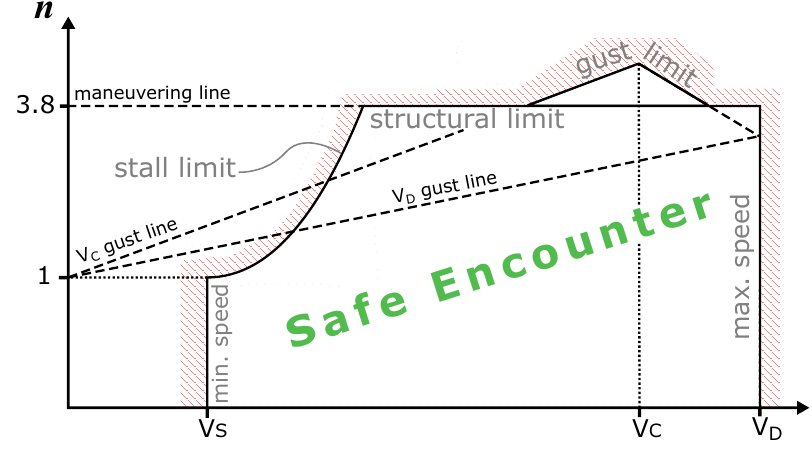
Figure 1. Qualitative V - n diagram for light and very light aircraft. Only positive load factors are represented. If the maximum load factor arising during a turbine wake encounter falls in the area within the red hatching, the encounter can be considered